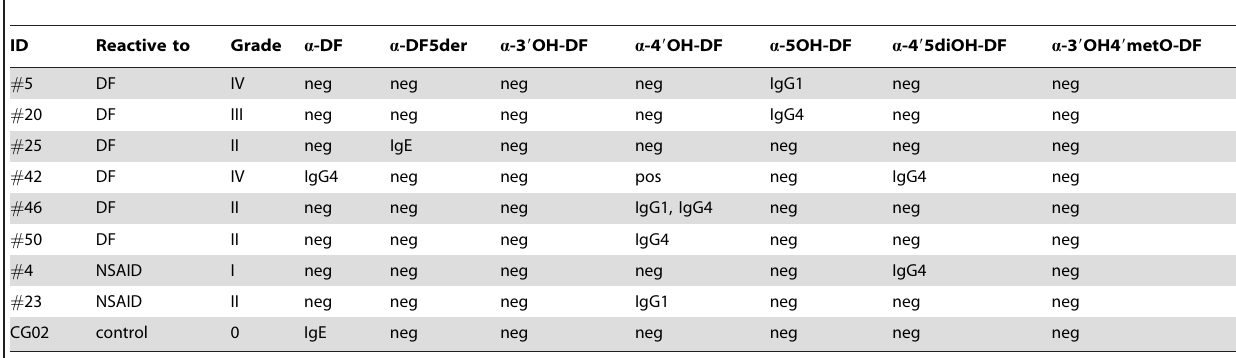
Table 1. Summary of positive ELISA results of antibody reactivity against hapten-HSA conjugates.